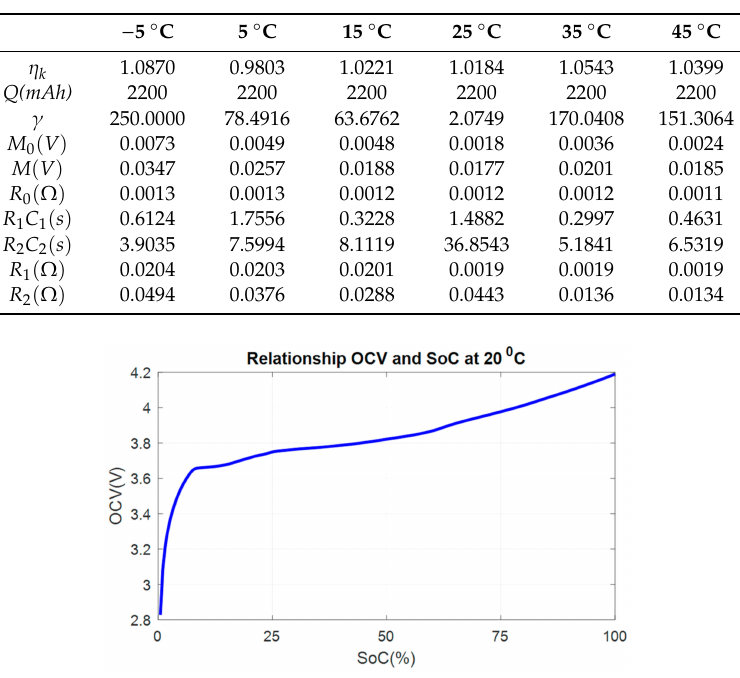
Figure 6. The relationship between open-circuit voltage (OCV) and SoC at 20 ◦ C.